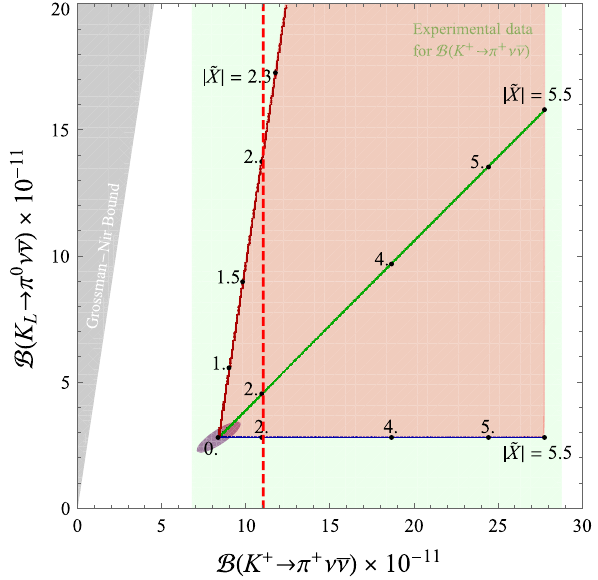
Fig. 2 New physics with one light right-handed neutrino. The green line illustrates the case ˜ X real and the pink region illustrates the case | ˜ X | ≤ 5 . 5. The purple marks the SM 1 σ region and the green marks the 90% c.l. from BNL-787 combined with BNL-949. The red and blue lines on the boundary of the pink region correspond to a new physics = (π/ 2 or 3 π/ 2 ) and φ + φ λ = ( 0 or π) phase given by φ + φ λ t t respectively. Finally the vertical dashed red line marks a possible future limit for B K + at 1.3 times the